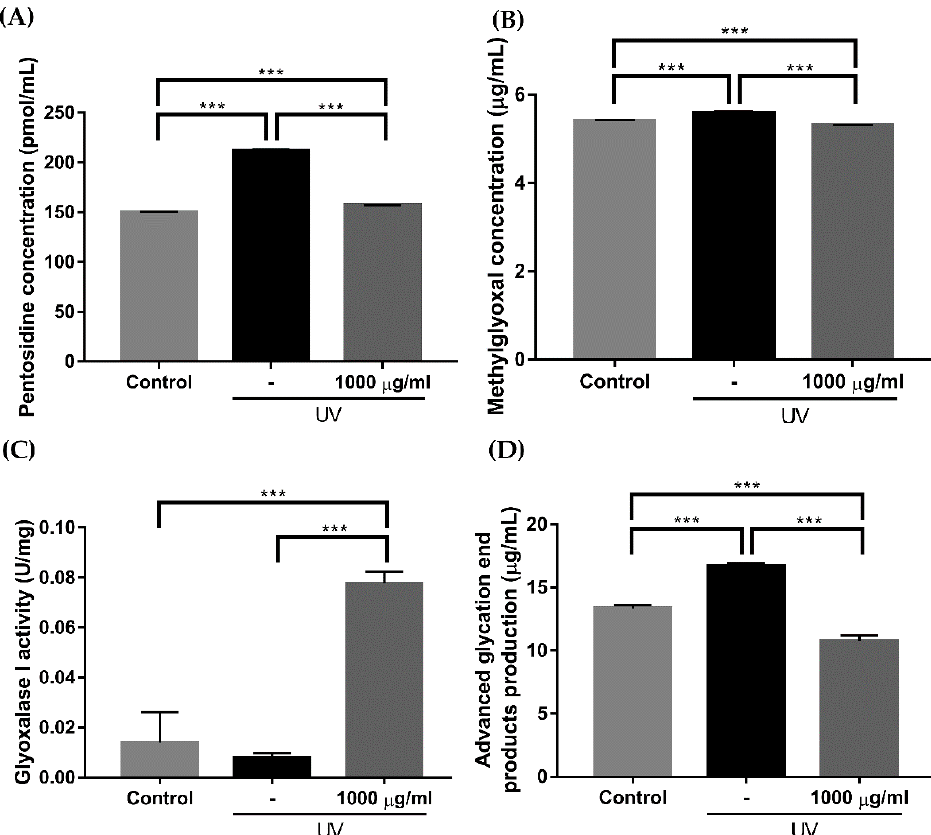
Figure 8. Comparison of the pentosidine, methylglyoxal, glyoxalase 1 activity, and advanced gly- cation end product (AGE) production in HDF cells before and after the treatment. Pentosidine, methylglyoxal, and AGE production was induced by 10 mJ/cm 2 of UVB irradiation ( A , B , D ). The induced pentosidine, methylglyoxal, and AGE concentrations were significantly reduced after treat- ment with 1000 μ g/mL of EverCTP TM (NEWTREE Co., Ltd., Seoul, Korea). Glyoxalase 1 activity was reduced by 10 mJ/cm 2 of UVB irradiation, and the reduced glyoxalase 1 activity was significantly increased with treatment of 1000 μ g/mL of EverCTP TM ( C ); *** p < 0.005, independent samples t -test. HDF, human dermal fibroblast; ultraviolet-B; UV, ultraviolet.